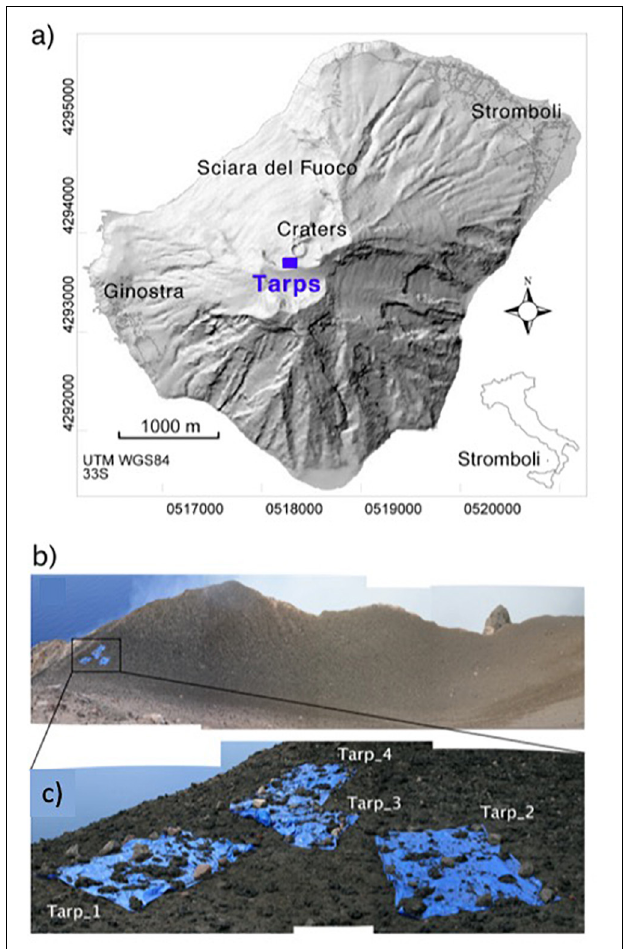
FIGURE 1 | (a) Stromboli (DEM in shaded relief) with the position of collecting area (blue square). (b) View on the crater area showing the sample site, and (c) the plastic sheets covered by fragments.